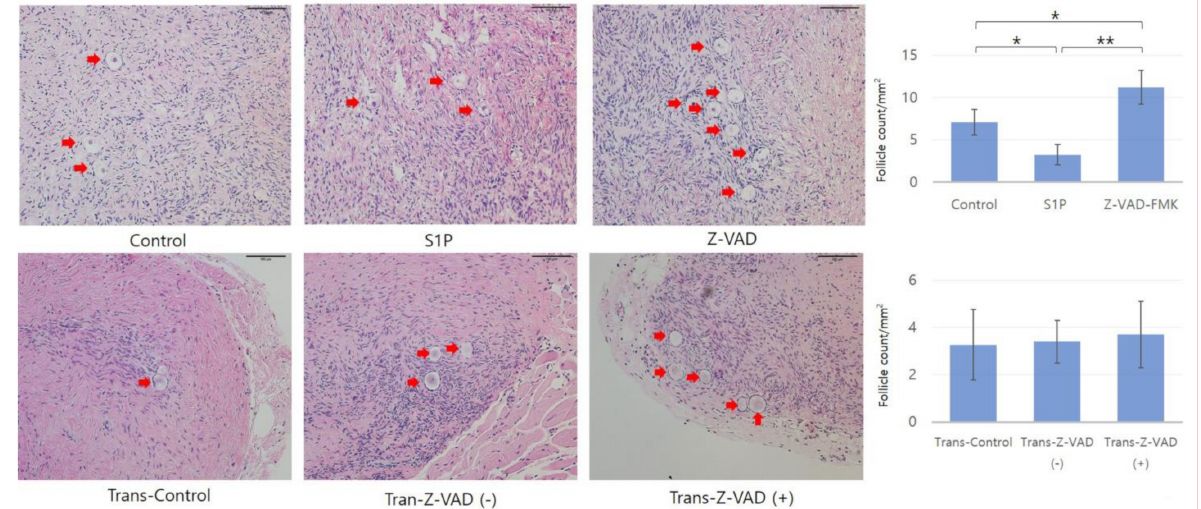
Figure 2. Histopathological findings and primordial follicle density in frozen–thawed human ovarian tissues and human ovarian tissues after xenotransplantation (magnification × 200). Student’s independent t-test showed that the follicular density was significantly different among the three groups (each group, n = 20, * p < 0.05, ** p < 0.005)) in frozen–thawed human ovarian tissue. However, there was no significant difference in follicle density among three groups (control: n = 10, trans-Z-VAD (-) and (+): n = 20) in human ovarian tissue after transplantation. Red arrows indicate primordial follicles. * p <